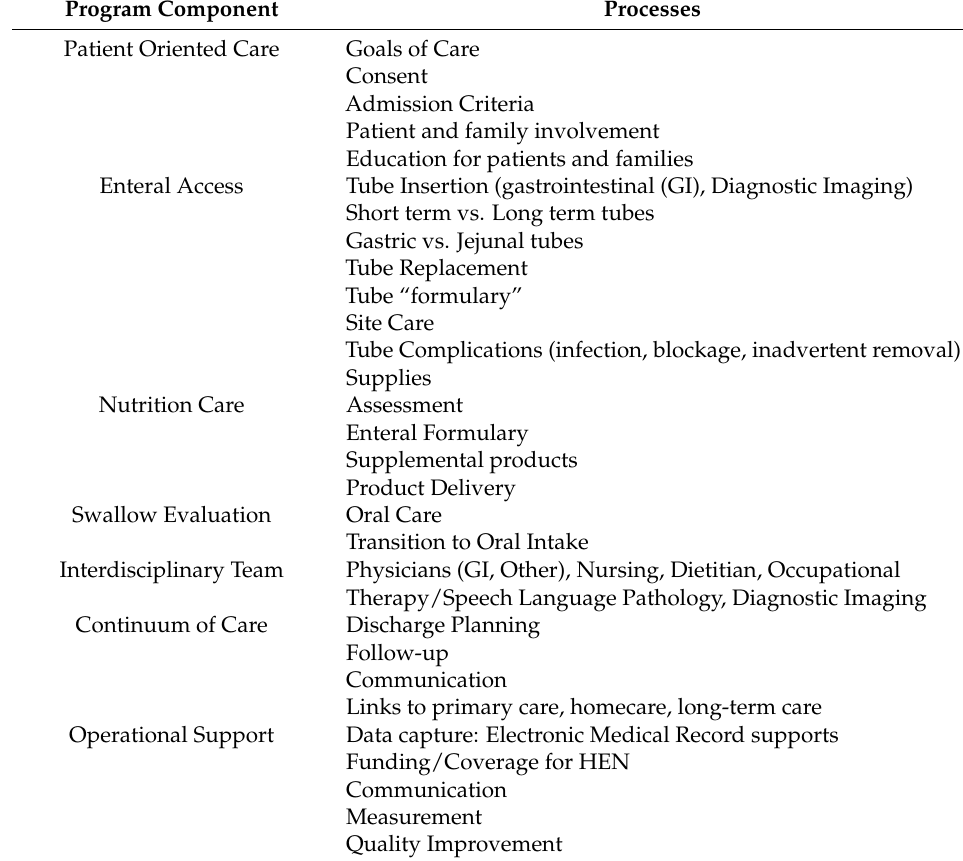
Table 3. Standardized HEN Program